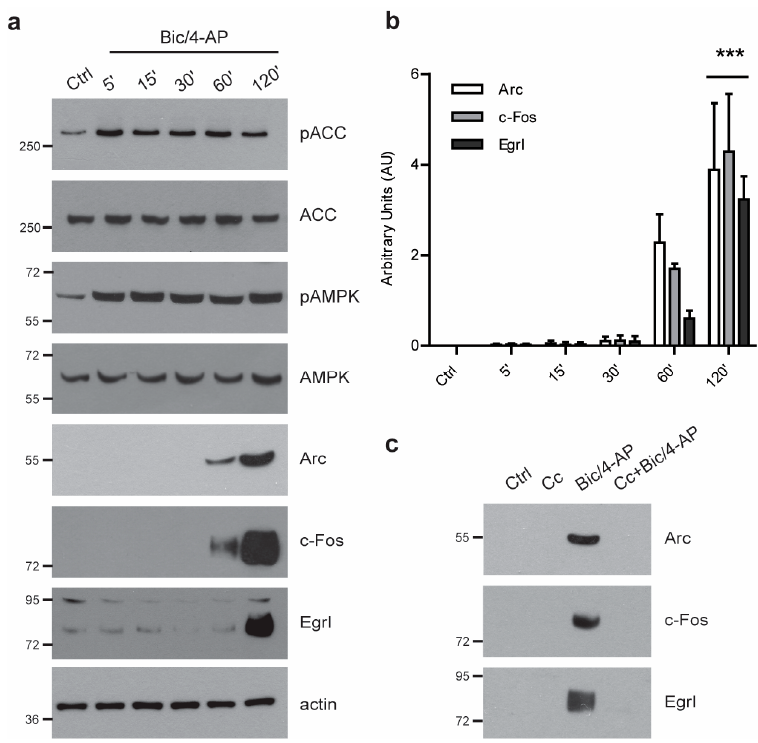
Figure 1. AMP-activated protein kinase (AMPK) is required for the expression of immediate early genes (IEGs) following glutamatergic activation. ( a ) Primary neurons at 15 days in vitro (DIV) treated with bicuculline and 4-aminopyridine (Bic/4-AP) (50µM/2.5mM) for the indicated time were subjected to immunoblotting with anti- phospho-AMPK (pAMPK), phospho-acetyl-CoA carboxylase (pACC), acetyl-CoA carboxylase (ACC), total AMPK, Arc, c-Fos, EgrI, and actin antibodies. Results are representative of at least four experiments. ( b ) Quantification of Western blot (WB) as in ( a ) showing Arc, c-Fos, and EgrI expression. Results show mean ± SD ( n = 4). One-way ANOVA followed by Bonferroni’s post-hoc test were used for evaluation of statistical significance, * p < 0.05, *** p < 0.001 compared to control condition. ( c ) Primary neurons at 15 DIV were pre-treated for 20 min in presence or absence of the AMPK inhibitor Compound C (Cc, 10 µ M) prior to being treated with Bic/4-AP (50 µ M/2.5mM, 2 h). Cell lysates were subjected to immunoblotting with anti-Arc, c-Fos, EgrI, and actin antibodies. Results are representative of at least four experiments.